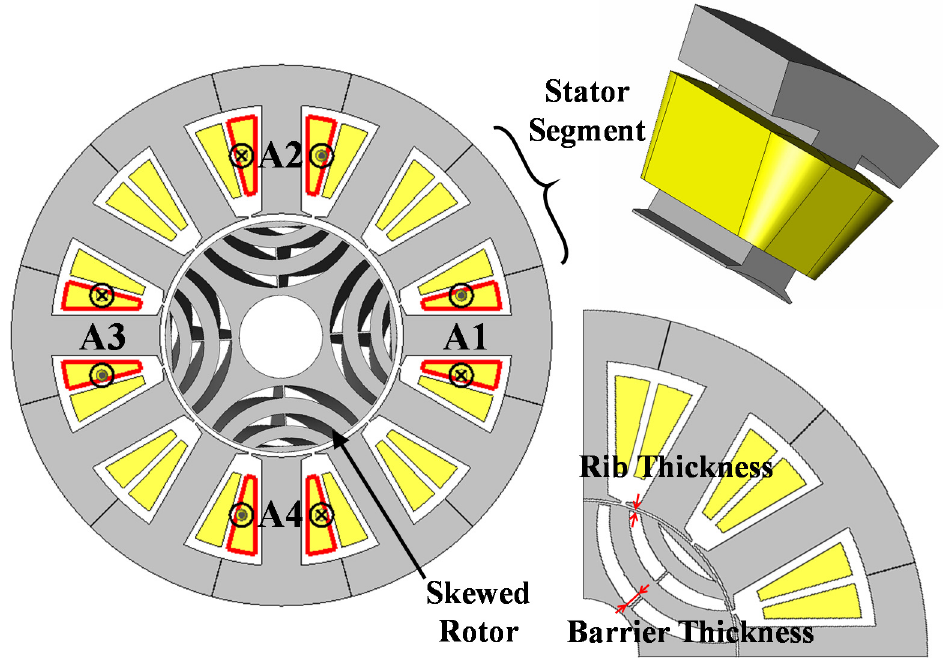
Figure 1. Topology of the 12/4 SynRM with concentrated windings with stator module and a quarter part.